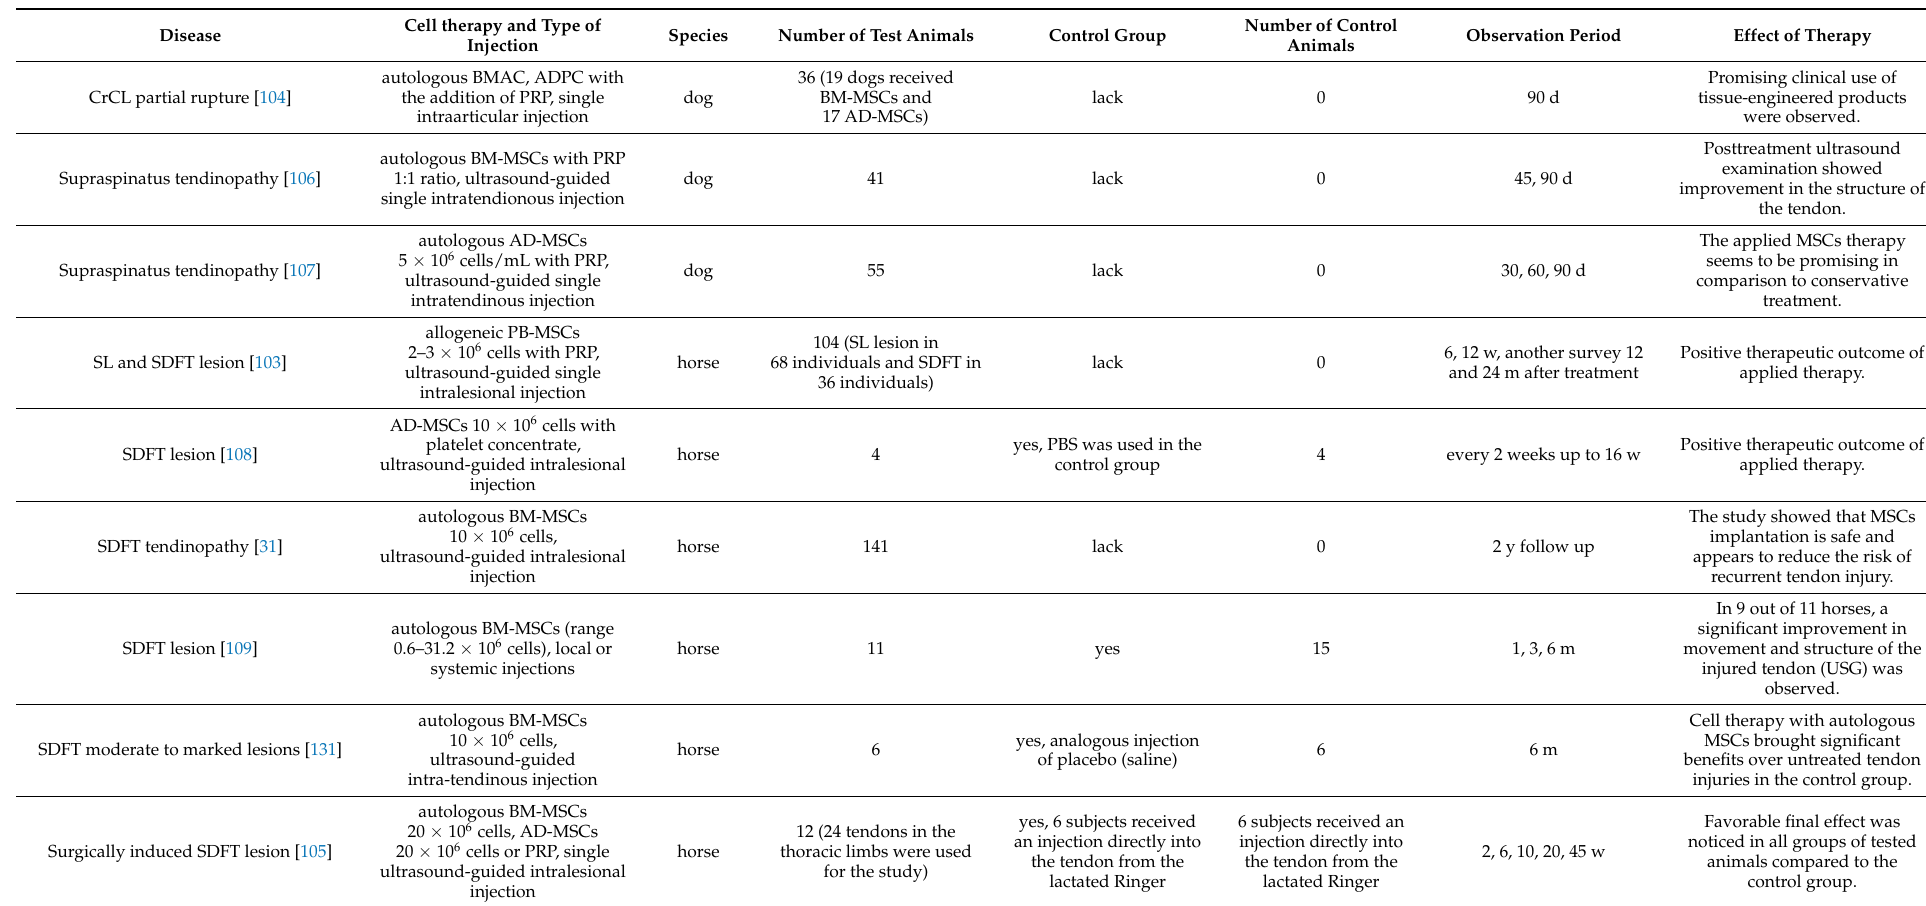
Table 2. A collection of selected papers describing the use of MSCs in the treatment of injuries of the tendo-ligamentous apparatus in animals. Abbreviations: CrCl —cranial cruciate ligament, BM-MSCs—bone marrow derived mesenchymal stem cells, BMAC—bone marrow aspirate concentrate, AD-MSCs—adipose derived mesenchymal stem cells, ADPC—adipose-derived progenitor cells, PRP —platelet rich plasma, SL—suspensory ligament, SDFT—superficial digital flexor tendon, PBS —phosphate buffered